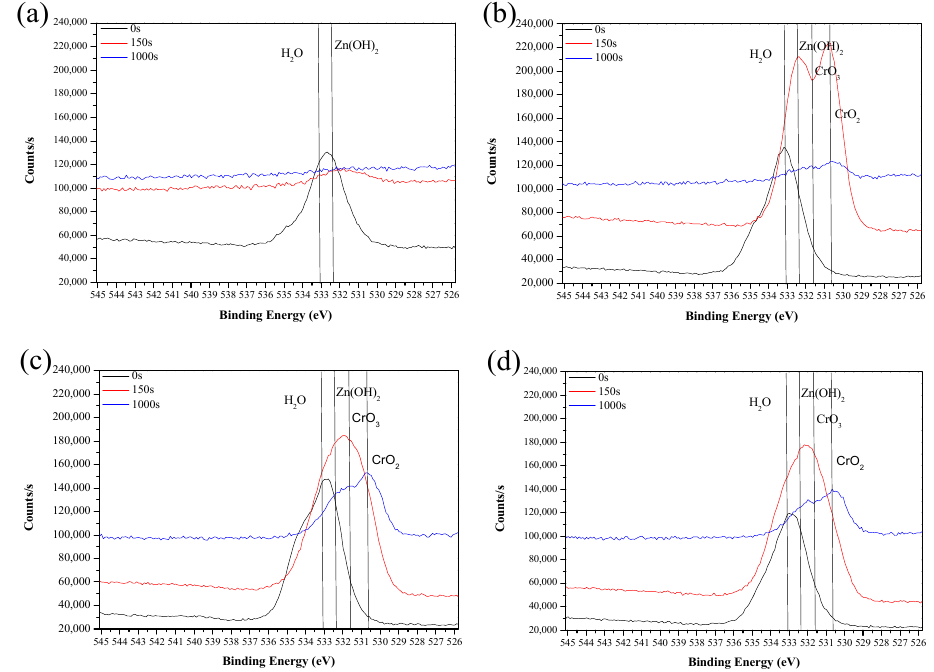
Figure 15. XPS spectra: O 1s binding energies determined from O 1s scans of ( a ) Zn–Ni alloy, ( b ) NaF 0% 60 s chromium conversion treatment, ( c ) NaF 50% 60 s chromium conversion treatment, and ( d ) NaF 100% 60 s chromium conversion treatment.